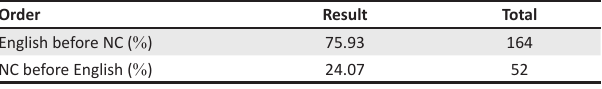
TABLE 2a: Order of language learning of lecturers . Order